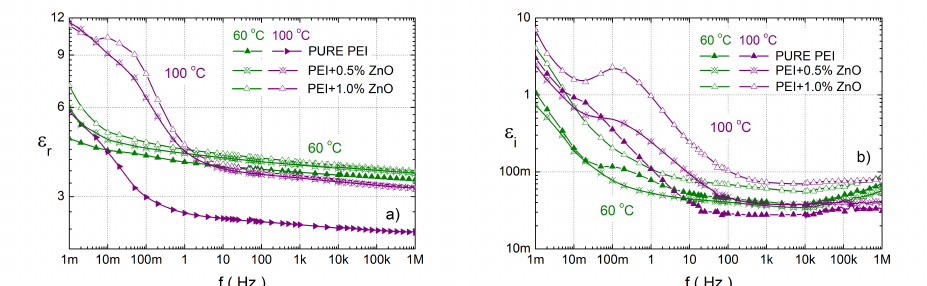
Figure 6. The frequency dependence of the real ( a ) and the imaginary ( b ) components of the complex relative permittivity for PEI and their various nanocomposites with ZnO at temperatures of 60 and 100 ◦ C.